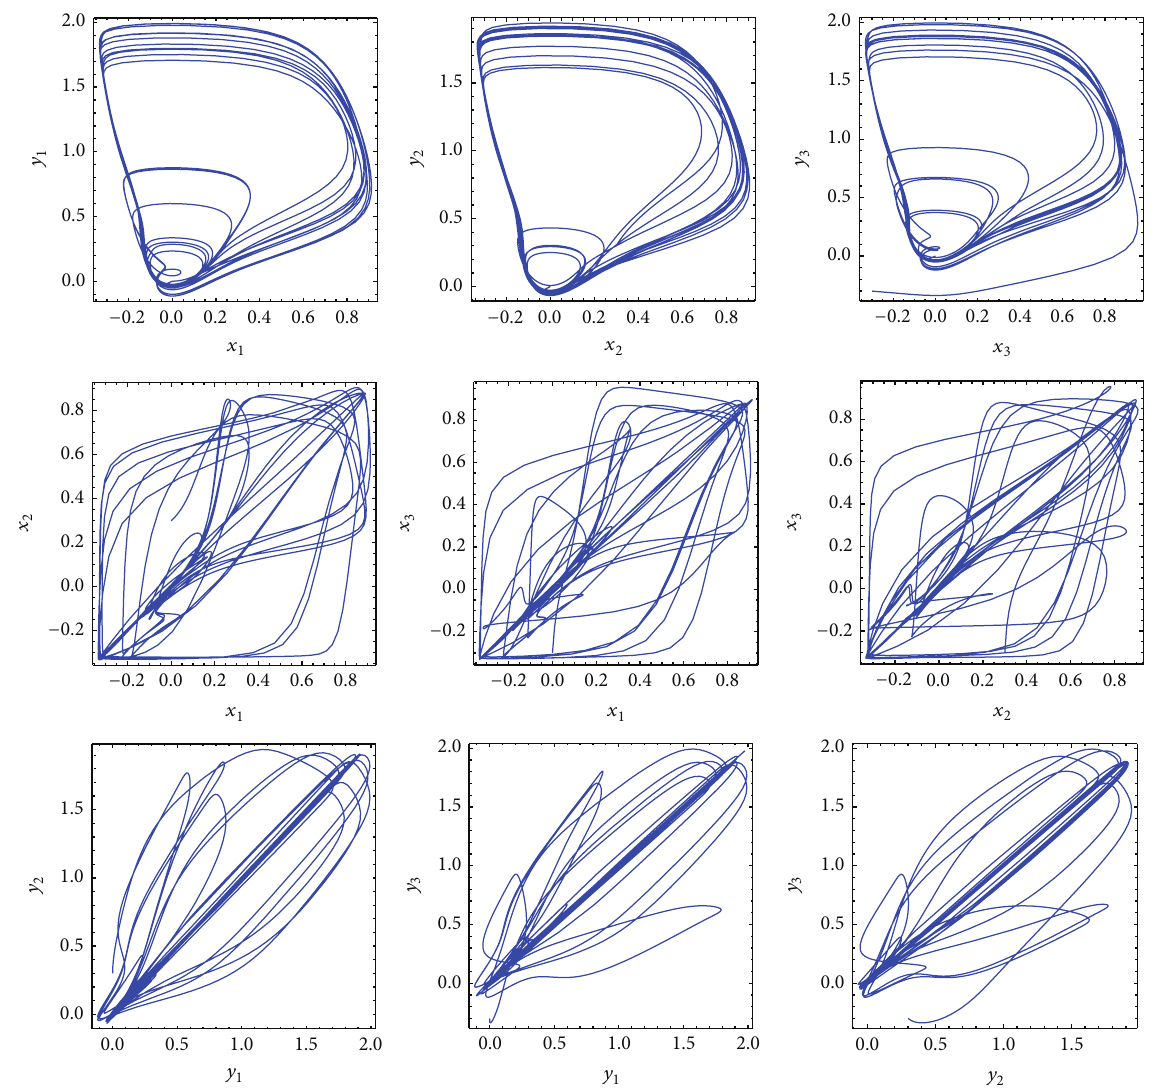
Figure 2: Phase plot of chaotic behavior of chaotic FHN neuronsis, with 𝛼 1 = 𝛼 2 = 𝛼 3 = 𝛼 4 = 𝛼 5 = 𝛼 6 = 1